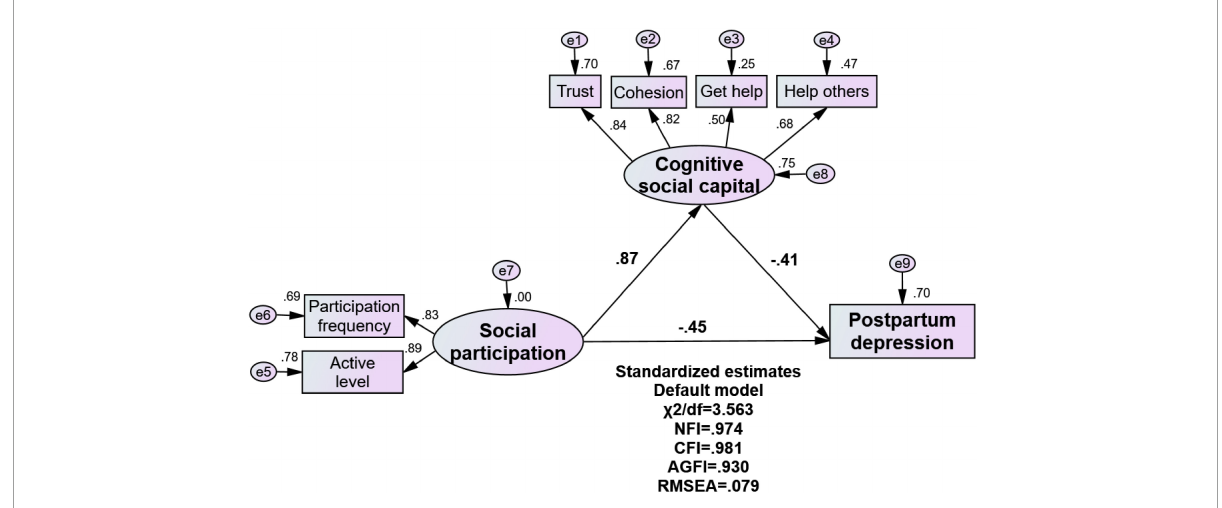
FIGURE2 The model of the mediating role of cognitive social capital between social participation and postpartum depression symptoms.